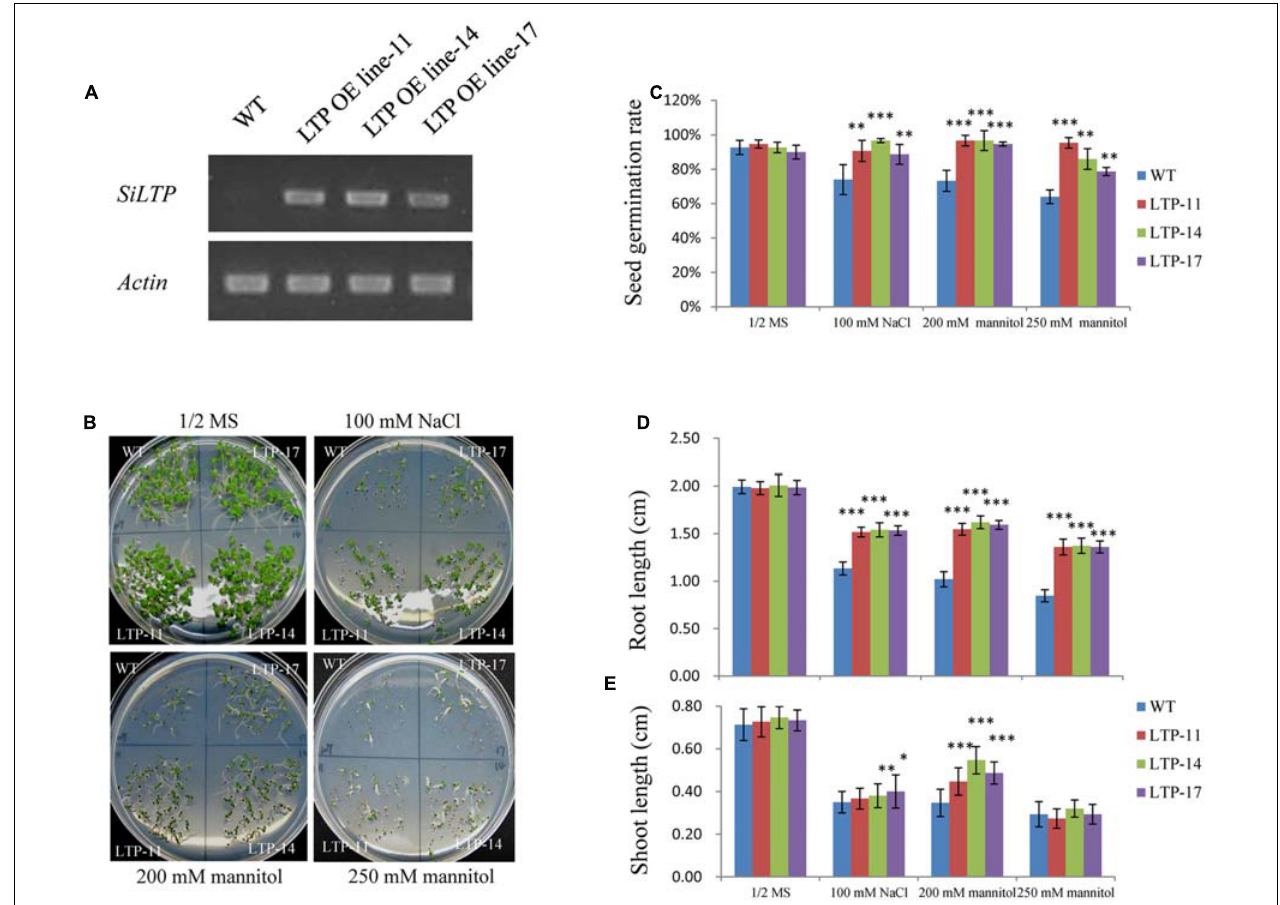
FIGURE 4 | Effects of NaCl and mannitol stresses on SiLTP transgenic tobacco seed germination. Expression levels of SiLTP in transgenic tobacco and WT plants (A) . NaCl or mannitol sensitivity of WT and transgenic plants (B) . Seeds of WT and transgenic lines were germinated and then grown for 8 days on medium independently supplemented with 0 (control), 100 mM NaCl, 250 mM mannitol, and 300 mM mannitol. The corresponding seed germination rates (C) , root lengths (D) , and shoot lengths (E) are compared. ∗ , ∗∗ , and ∗∗∗ indicate statistically significant differences at P < 0.05, P < 0.01, and P < 0.001 (Student’s t -test),